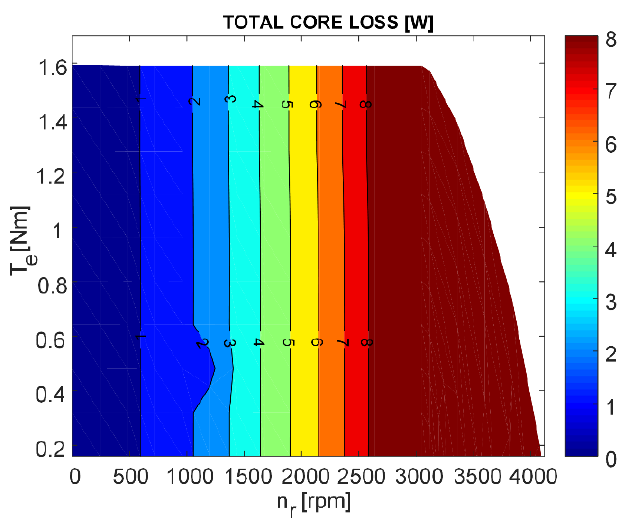
Figure 8. Shimano Steps IPM stator copper losses.